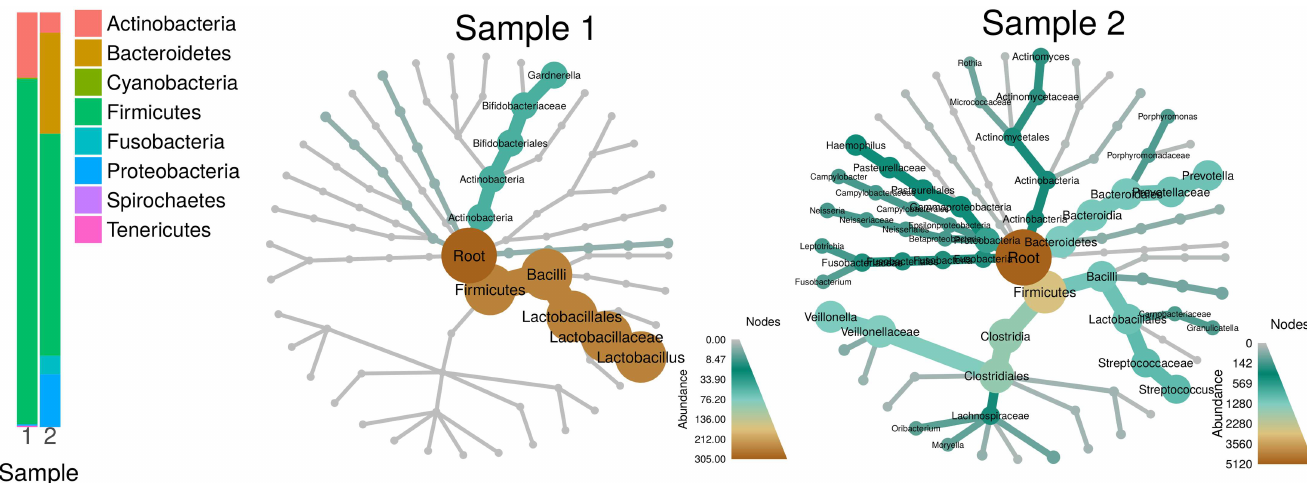
Fig 2. Heat trees allow for a better understanding of community structure than stacked bar charts. The stacked bar chart on the left represents the abundance of organisms in two samples from the Human MicrobiomeProject [5]. The same data are displayedas heat trees on the right. In the heat trees, size and color of nodesand edgesare correlated with the abundanceof organisms in each community. Both visualizations show communitiesdominated by firmicutes, but the heat trees reveal that the two samples share no families within firmicutes and are thus much more different than suggestedby the stacked bar